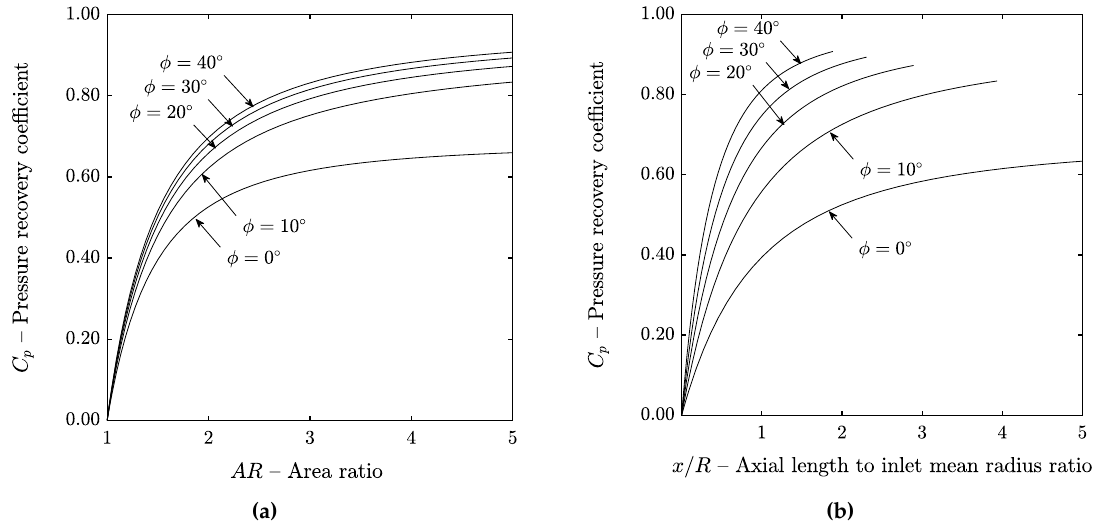
Figure 10. Influence of the mean wall cant angle on the pressure recovery coefficient as a function of the area ratio ( a ) and as a function of the axial length ( b